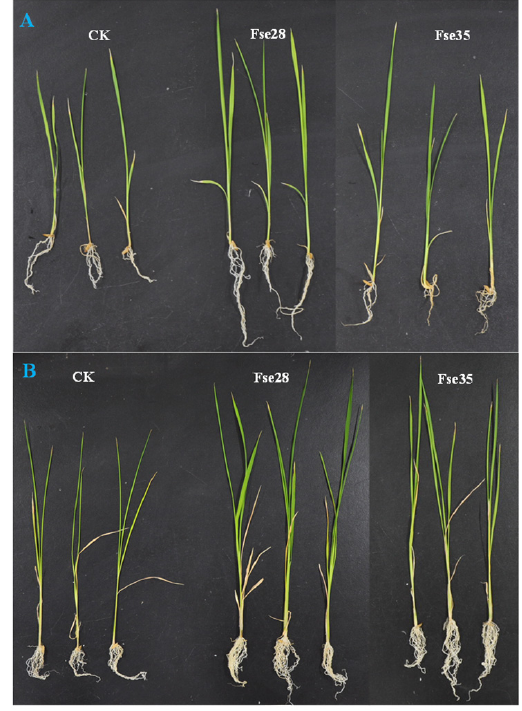
Figure 4. Effects of inoculating with PGPE bacteria on the growth of shoots and roots in rice seedlings after treatment for 10 and 20 days. Representative images are shown of rice seedlings with or without inoculation using endophytic bacteria for 10 and 20 days (( A ) and ( B ),